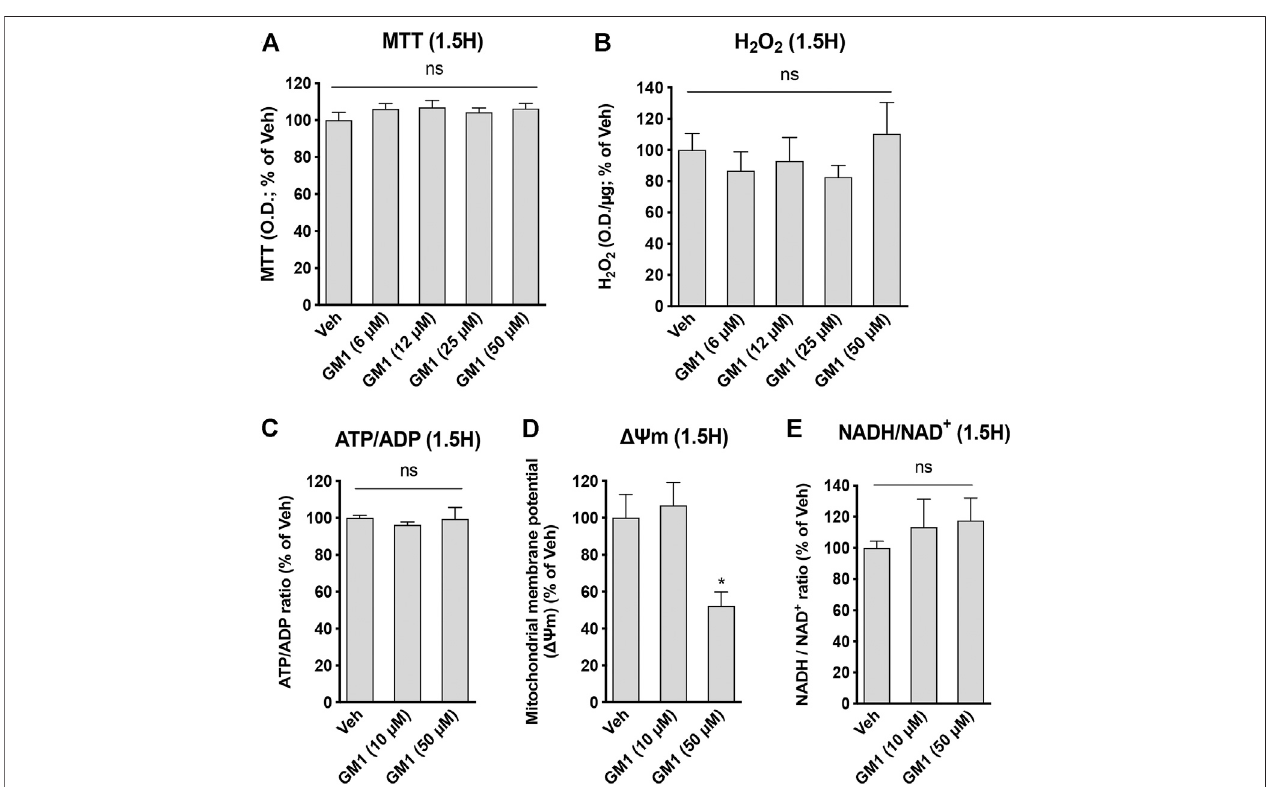
FIGURE2| ModulationofastrocyticmitochondrialactivityandredoxstatebyGM1. (A) MTTassayusedtomonitormitochondrialfunctionthroughoxidoreductase enzymes activity in astrocytes treated for 1.5 h with Veh (DMSO0.1%) or GM1 (6 – 50 μ M). Data are shown asthe average +SEM ofoptical density (OD) of mitochondrial reductase-induced formazan represented as % of Veh ( n (cid:2) 12). (B) Extracellular H 2 O 2 secreted by astrocytes after treatment with Veh (DMSO 0.1%) or GM1 (6 – 50 μ M) for1.5 h.Dataareshownastheaverage+SEMofH 2 O 2 levelsmeasuredbyOD( n (cid:2) 7 – 10). (C) ATP/ADPratioinastrocytestreatedfor1.5 hwithVeh(DMSO0.1%) or GM1 (10 and 50 μ M). Data are shown as the average +SEM of ATP/ADP ratio ( n (cid:2) 4). (D) Inner mitochondrial potential ( ΔΨ m) of astrocytes measured with JC1 dye after treatment with Veh (DMSO 0.1%) or GM1 (10 and 50 μ M) for 1.5 h. Data are shown as the average +SEM of JC1 dye level ( n (cid:2) 6). (E) NADH/NAD + redox ratio in astrocytes treated for 1.5 h with Veh (DMSO 0.1%) or GM1 (10 and 50 μ M). Data are shown as the average +SEM of NADH/NAD + redox ratio ( n (cid:2) 5 – 9). Statistical analyses consisted in one-way ANOVA followed by Dunnett ’ s post-hoc test; * p < 0.05, ** p < 0.01, *** p <